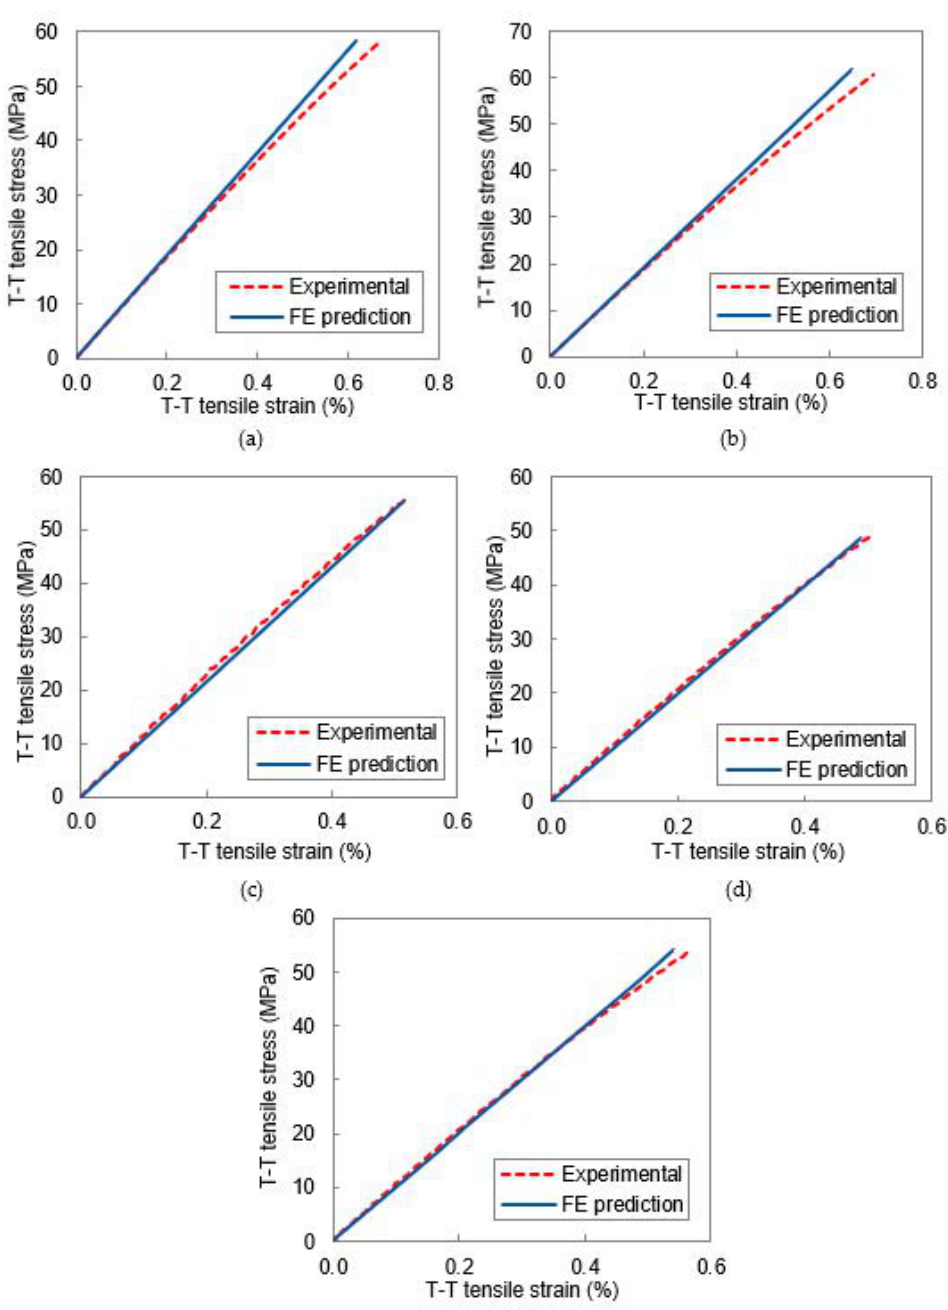
Figure 15. Experimental and finite element (FE) predicted stress–strain curves for ( a ) spool A, ( b ) spool B, ( c ) bi-lateral waist, ( d ) RARDE Type III, and ( e ) RARDE Type III (mini)